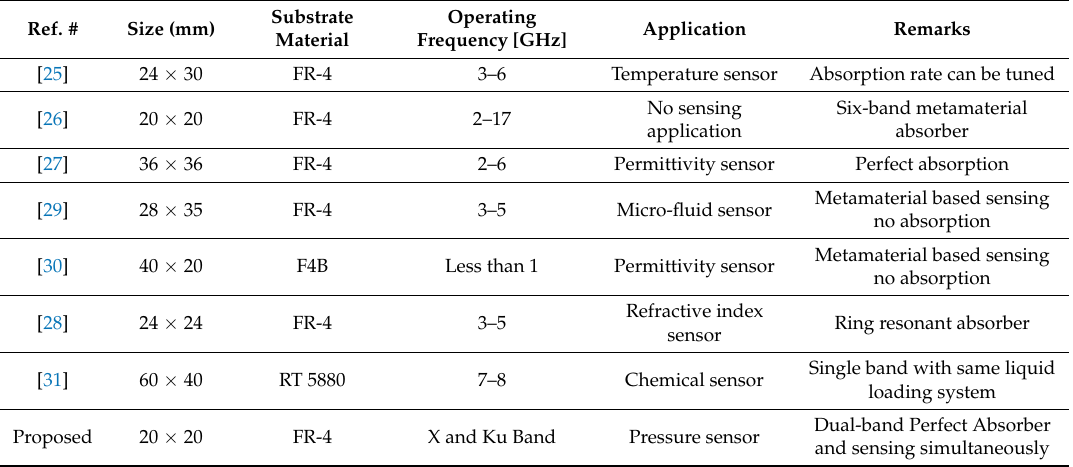
Table 4. Comparison of the MM absorber in other sensing